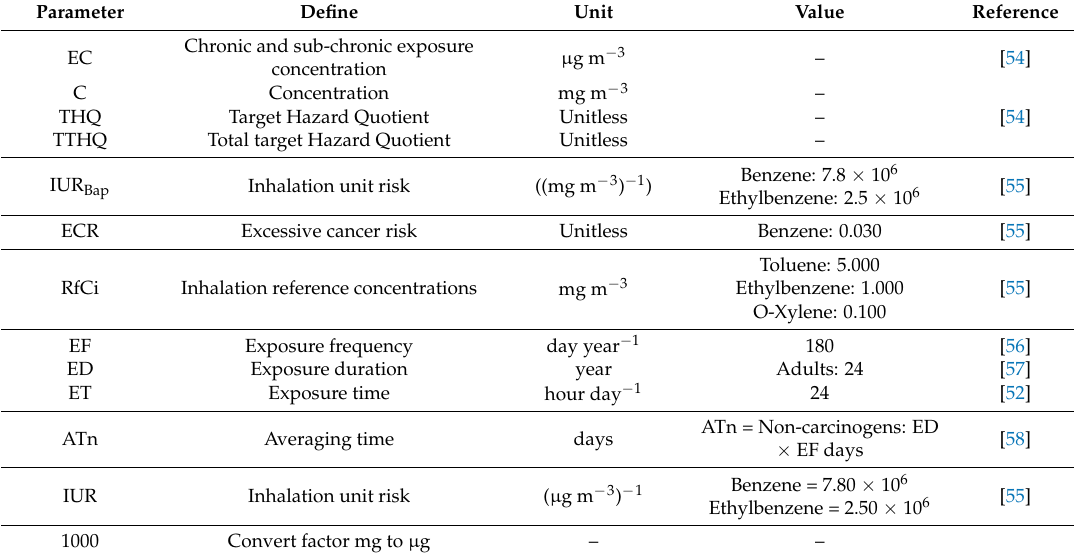
Table 2. Parameters included in the health risk assessment due to the exposure inhalation